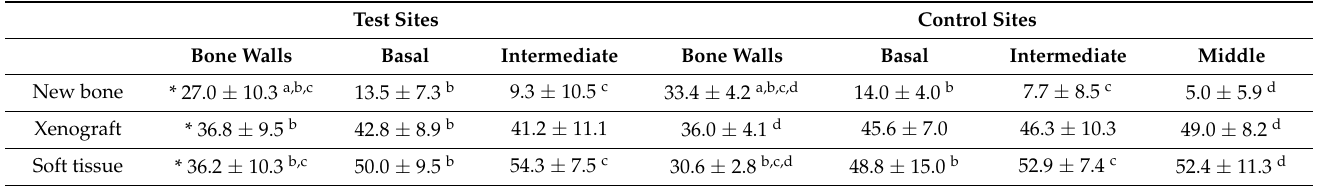
Table 6. Morphometric evaluation of the tissues after 8 weeks of healing in the various regions evaluated. Mean values ± standard deviation in percentages. Test sites with the inward window. Test Sites Control